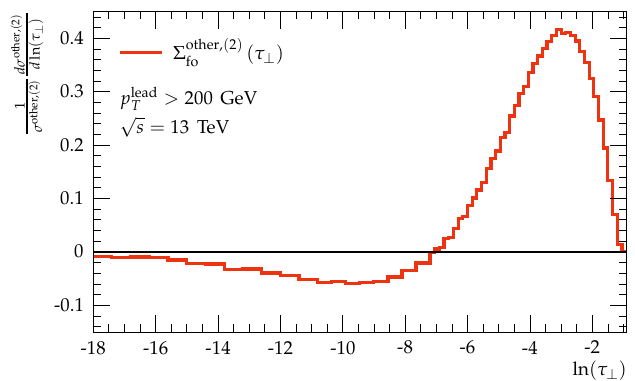
Figure 5 . The O ( α 2 ) contribution to the ‘other’ channel in the limit τ ⊥ → 0 . s